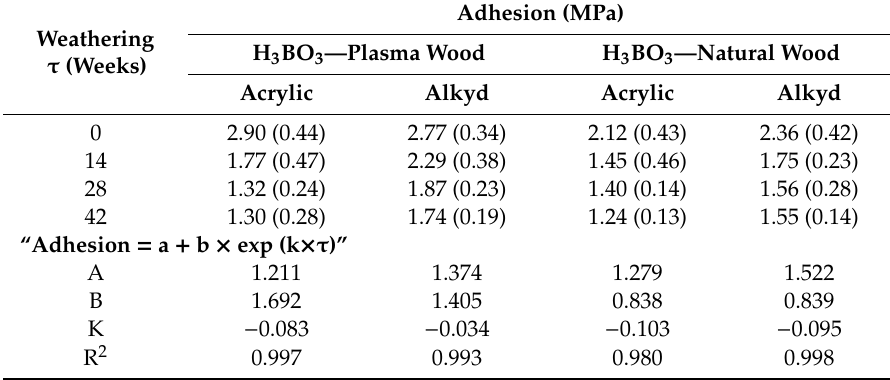
Table 3. The significant negative e ff ect of outdoor weathering on the adhesion between the coating (acrylic or alkyd) and the Norway spruce wood pre-treated with fungicide H 3 BO 3 —subjected to or not subjected to plasma